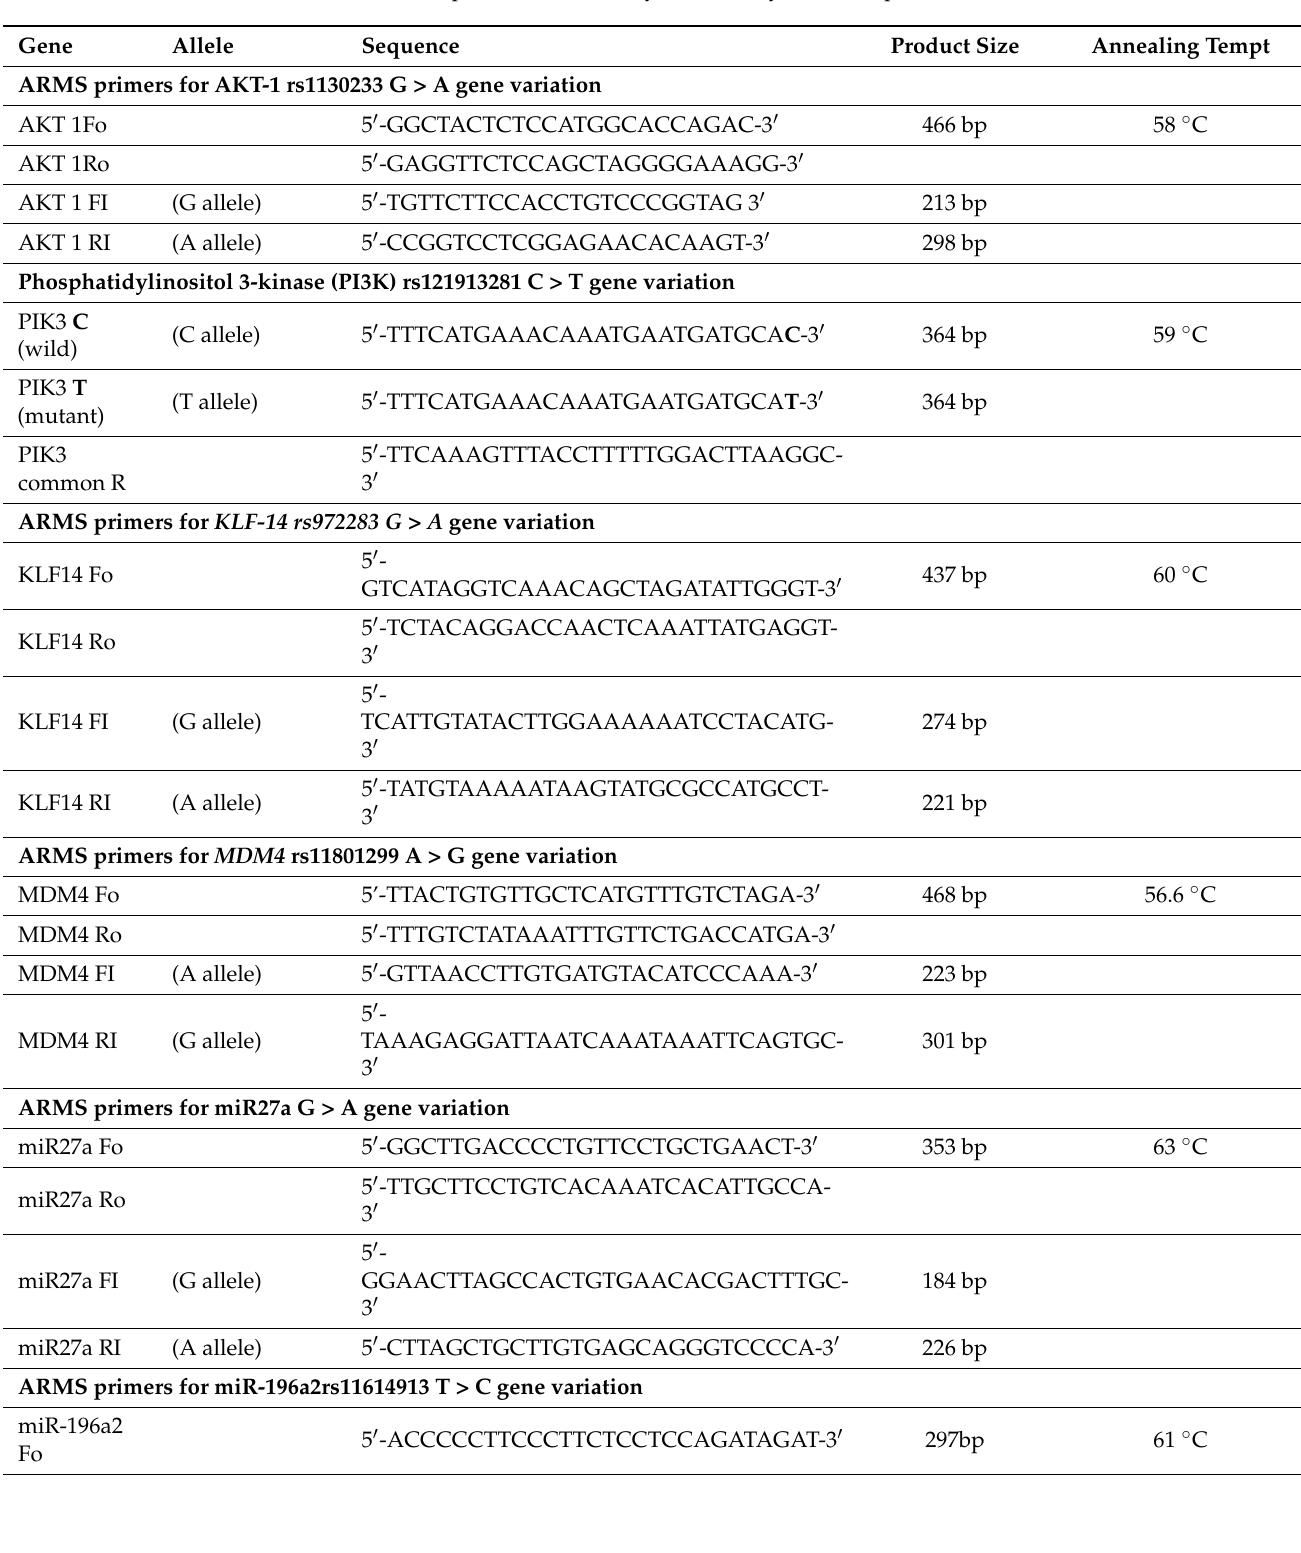
Table 1. Amplification-refractory mutation system PCR